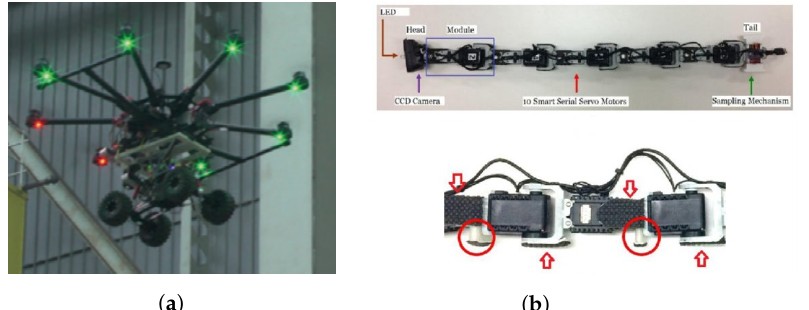
Figure 5. Examples of research robots: ( a ) Multi-rotor carrying a UGV. Reproduced, with permission, from Reference [80]. ( b ) Snake-like robot ( top ) and detail of the silicon pads ( bottom ). Reproduced, with permission, from Reference [84]; published by SAGE, 2018, under the terms of the